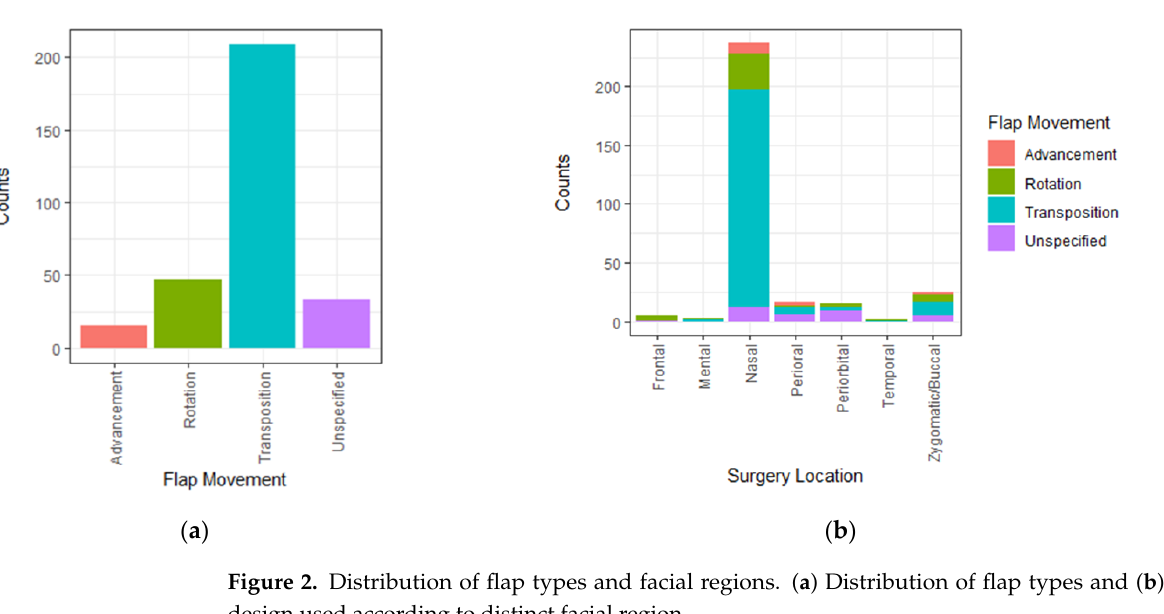
Table 4. Complications related to FTSGs and local